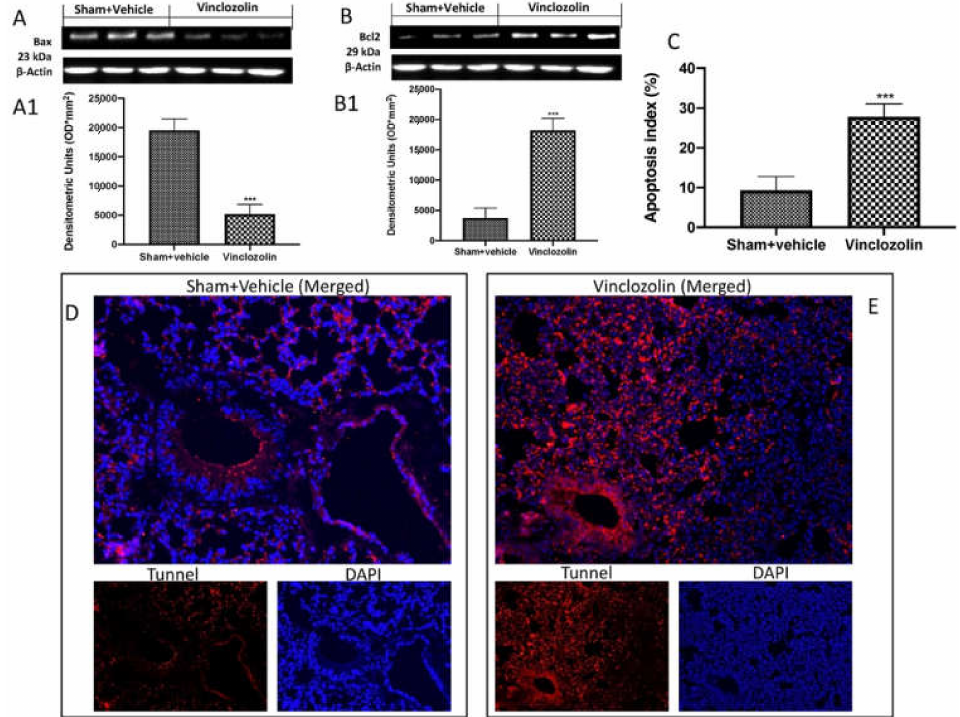
Figure 7. Vinclozolin exposure induced lung apoptosis. Western blots and quantification of lung tissue from Bax ( A , A1 ) and Bcl-2 ( B , B1 ); TUNEL images from lung tissue of sham animals ( D ) and vinclozolin-treated animals ( E ); apoptotic index ( C ). After 28 days of vinclozolin exposure, we found a significant increase in cell death. Values are the means ± SD of 6 mice per group. Images shown are representative of the results obtained. *** p < 0.001 vs.